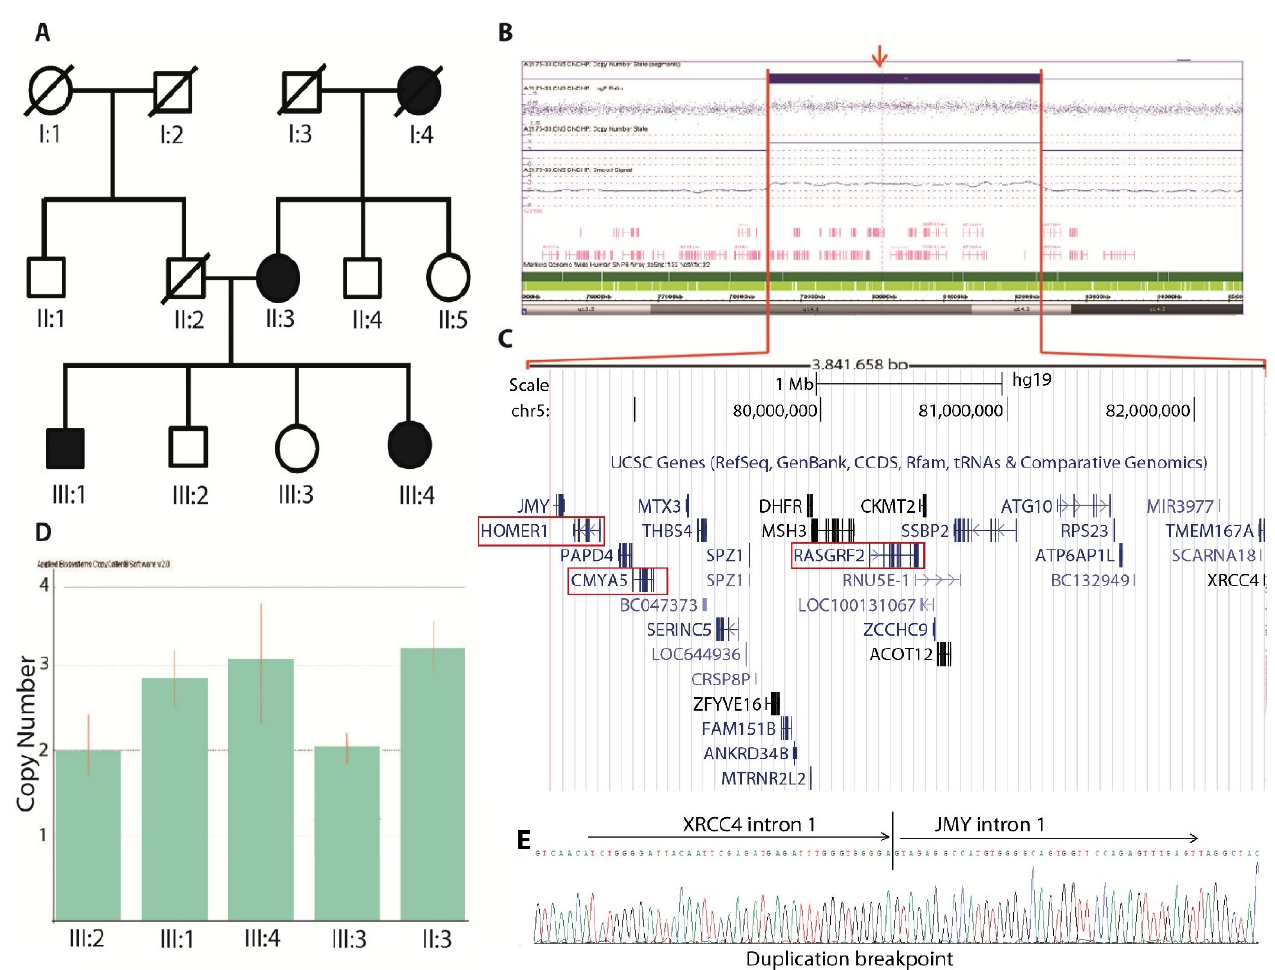
Figure 1. Identification and characterization of duplication at 5q14.1_q14.2 in family A: ( A ) The pedigree of a non-consanguineous Pakistani family with a possible autosomal dominant inheritance of schizophrenia. ( B ) Affymetrix SNP 6.0 data of the proband showing the duplication, ~3.84 Mb in size. ( C ) Screenshot of UCSC genome browser hg19 builds showing 36 reference sequence genes present in the 5q14.1 duplication area. The genes highlighted in red rectangles are previously implicated in schizophrenia. ( D ) Confirmation of the duplication in all available family members using the TaqMan ® Copy Number Assay. The predicted copy number state is indicated on the y -axis, “C” indicates the control subject. ( E ) The chimeric sequence between the XRCC4 and JMY genes was validated by Sanger sequencing and by a single split mate-pair read.